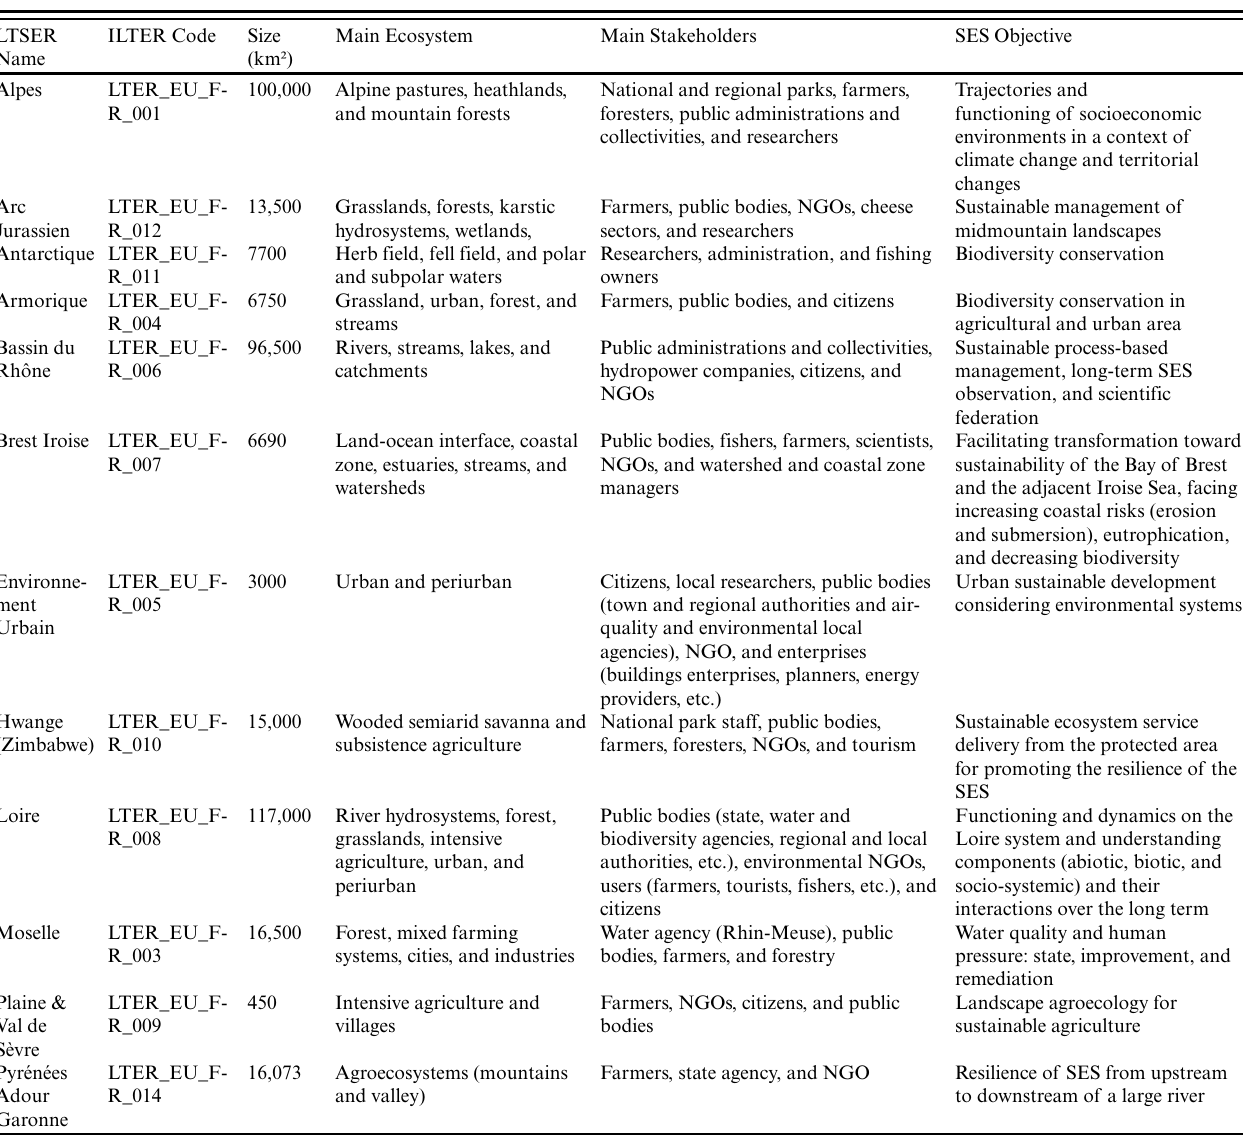
Table 1 . Description of the 14 research platforms of the French long-term social-ecological research (LTSER) network. ILTER, international long-term ecological research; SES, social-ecological